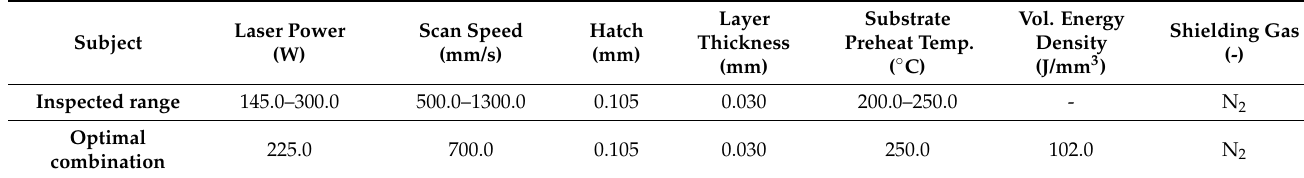
Table 2. Used L-PBF parameter setting for hot-work tool steel AISI H10 with a focus diameter of 0.150 mm (temp. = temperature; Vol. = Volume).